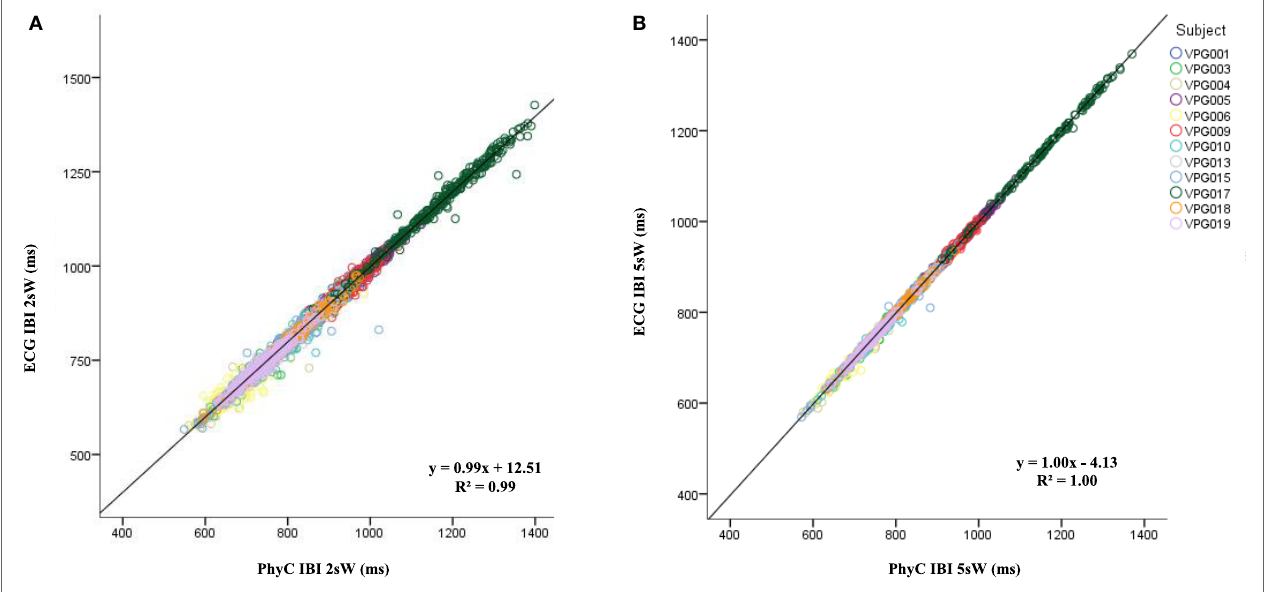
FigUre 6 | Scatter plot for average window interbeat interval (IBI) from the electrocardiogram (ECG) and PhysioCam (PhyC) color marked by participant. (a) Scatter plot of the PhyC vs ECG for 2 s average windows IBIs. (B) Scatter plot of the PhyC vs ECG for 5 s average